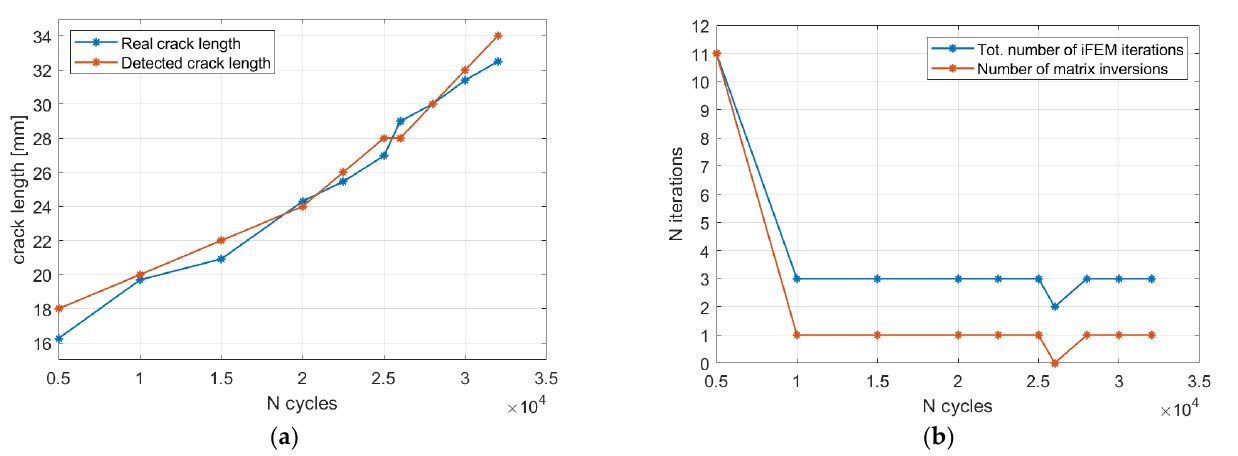
Figure 17. Likelihood trend with the 1 mm model: ( a ) experimental strain acquired at 24.3 mm (20,000 cycles); ( b ) experimental strain acquired at 32.5 mm crack length (32,000 cycles).